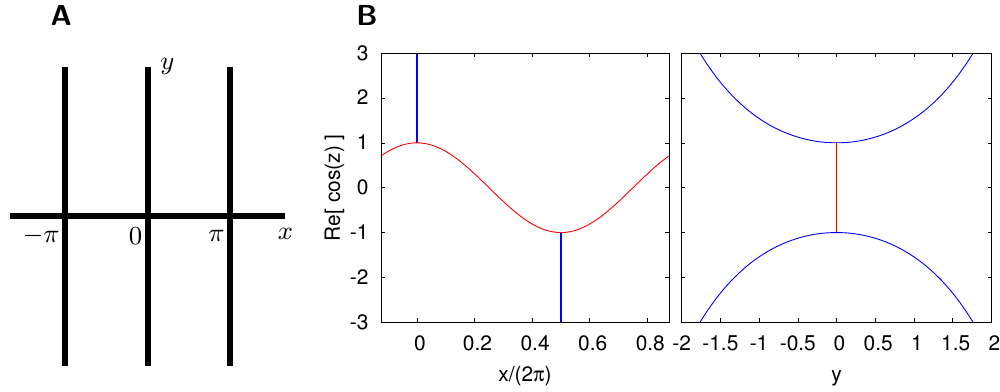
Figure 11. Illustration of the bands of the holomorphic function cos p z q . ( A ) Schematic illustration of the forked paths, where Im t cos p z qu “ 0 in the imaginary plane, where x “ Re t z u and y “ Im t z u . ( B ) Re t cos p z qu in a CBS diagram, as in Figure